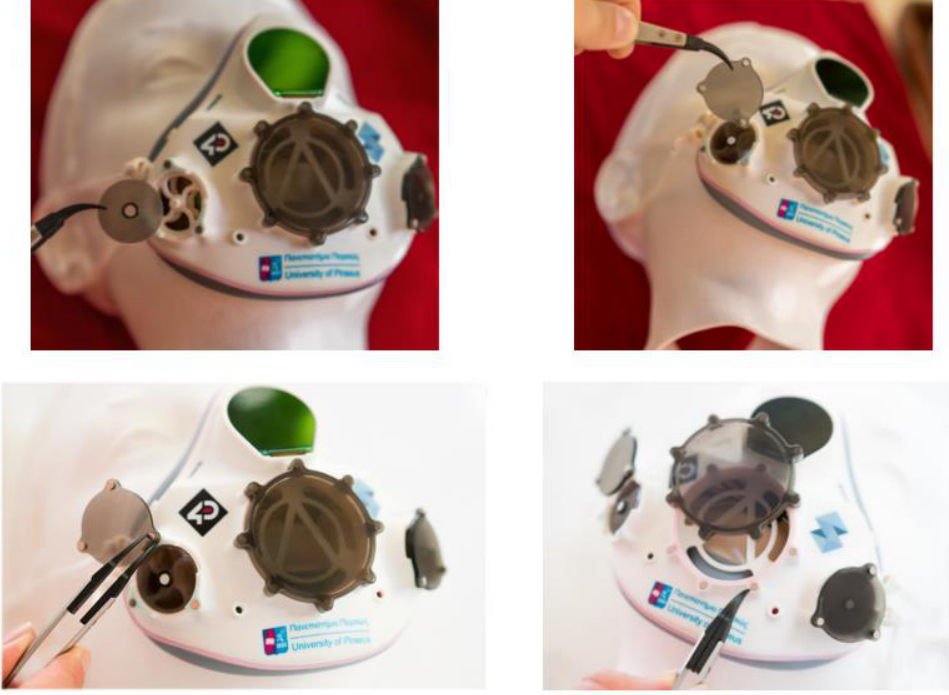
Figure 7 . Assembly of the exhaust valve, main filter, and the corresponding covers on the main